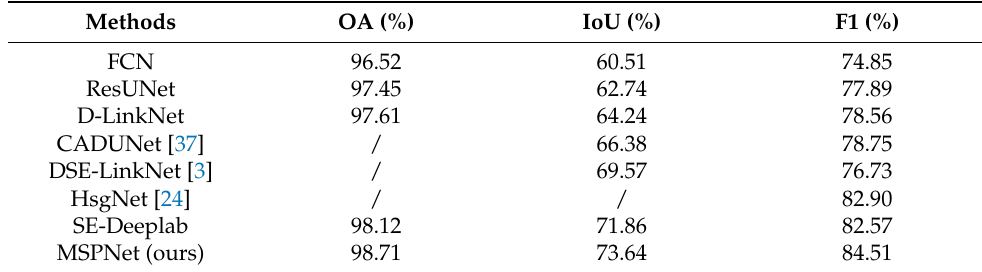
Table 3. Results of the comparative experiments.